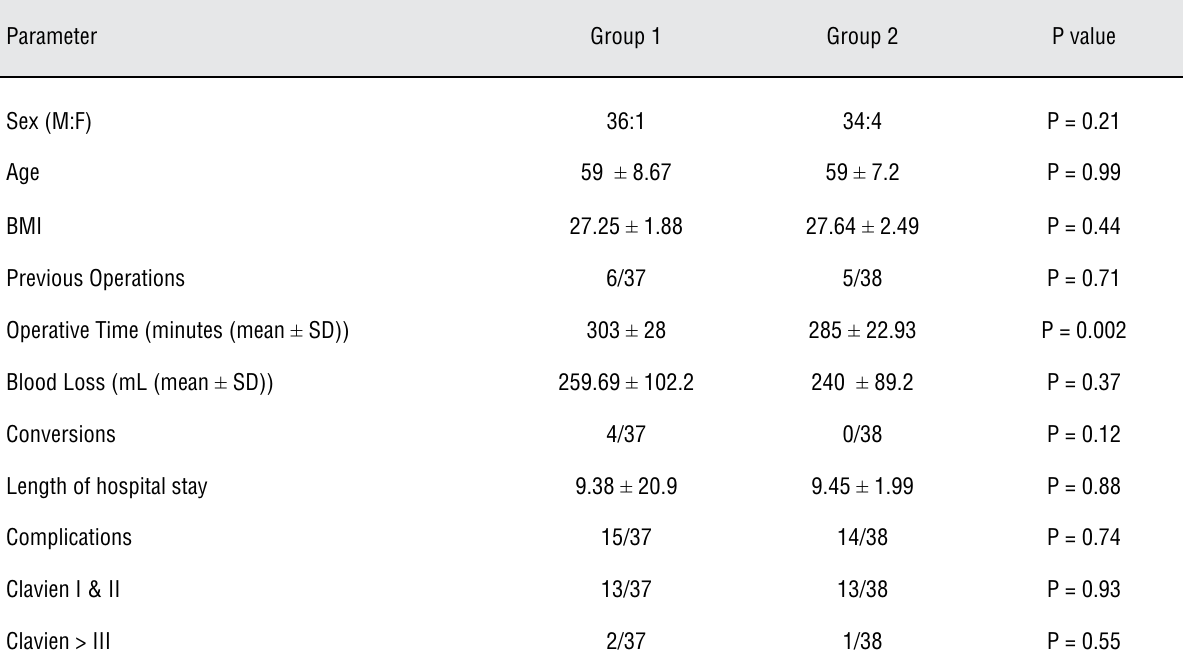
Table 3 - comparison between the initial and final cohort of